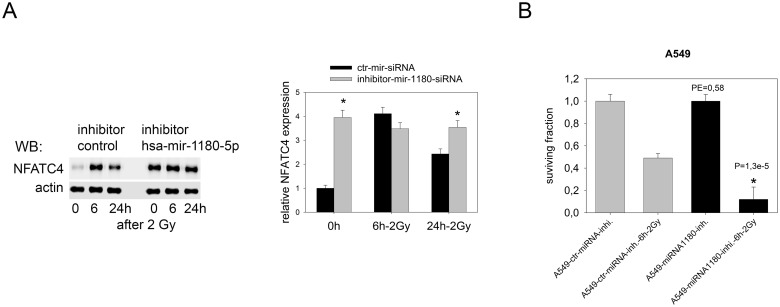
Role of hsa-mir-1180-5p in NFATC4 protein expression and function.A: Inhibition of radiation-induced downregulation of NFATC4 protein levels by blocking the effect of hsa-mir-1180-5p. A549 cells were treated with the hsa-mir-1180-5p inhibitor or inhibitor control for 24 h and irradiated with 2 Gy of radiation. Cells were lysed at the indicated time points and NFATC4 expression was quantified by western blotting. Densitometric quantification was performed on samples from three independent experiments (two-sample t-test combined with Bonferroni’s correction; *p< 0.016 compared to ctr-mir-siRNA). B: A colony formation assay was used to determine the effect of the hsa-mir-1180-p5 inhibitor on the plating efficiency and radio-sensitivity of A549 cells (*p< 0.016 compared to ctr mir-inhibitor).